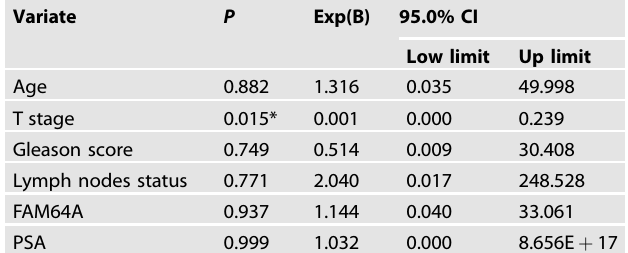
Table 4. Multivariate Cox-regression analysis for patients after surgery